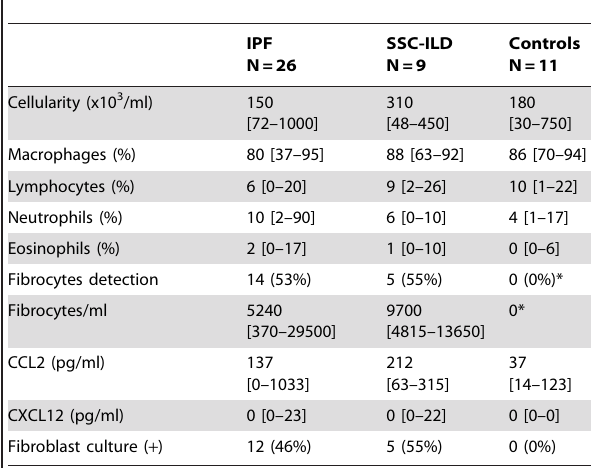
Table 2. Bronchoalveolar lavage